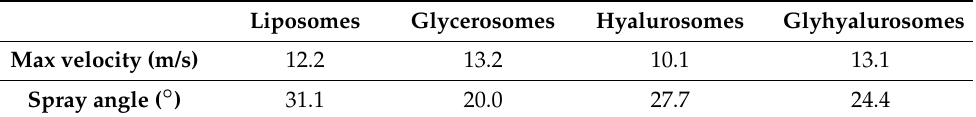
Table 3. Average maximum velocities and spray angle generated by liposomes, glycerosomes,